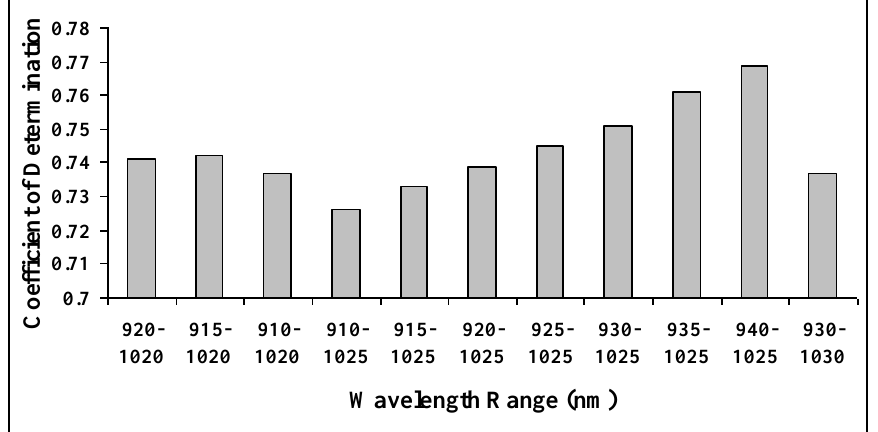
Figure 3. Calibration accuracies from different range of wavelength conducted on interactance